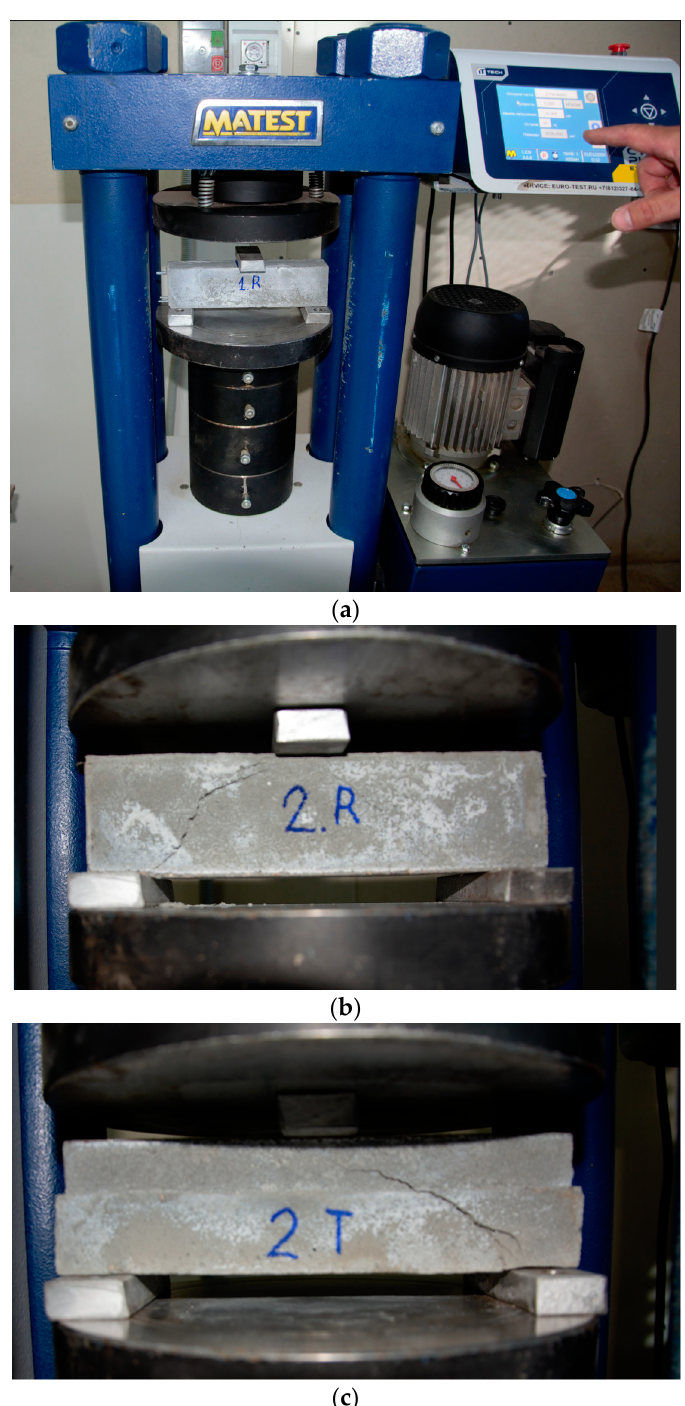
Figure 12. Sample testing process in the laboratory LLC “Donskaya Stroitelnaya Laboratoriya” with characteristic patterns of sample destruction: ( a )—Matest test press, ( b )—sample 2R sample test, ( c )—sample 2T test.